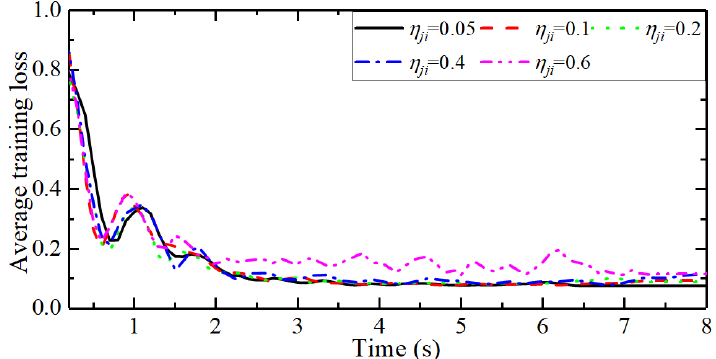
Figure 12. Average training loss curve under different η ji